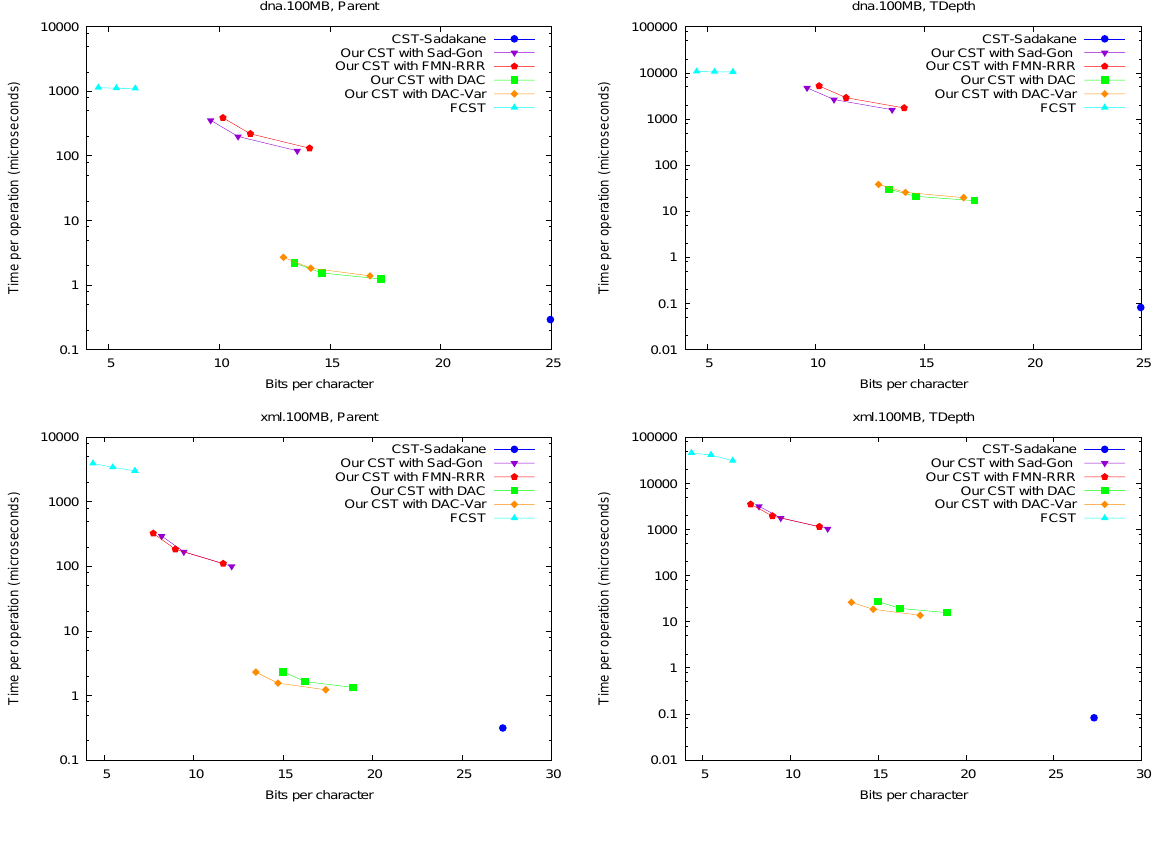
Figure 4. Space/Time trade-off performance for operations Parent and TDepth . Note the log